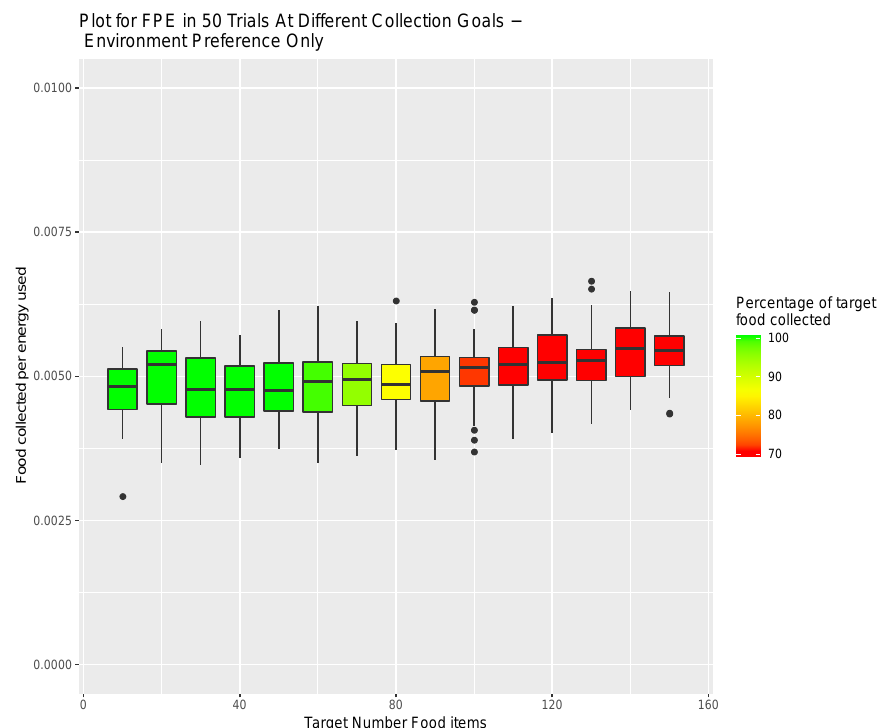
Figure 13. Hormone preference system tested in the environment containing two difference terrain types. Target number for items collected ranged from 10 to 150 items of food. Percentage of the items requested versus those collected by the end of the simulation is indicated by colour (Green 100% and Red < 70%).